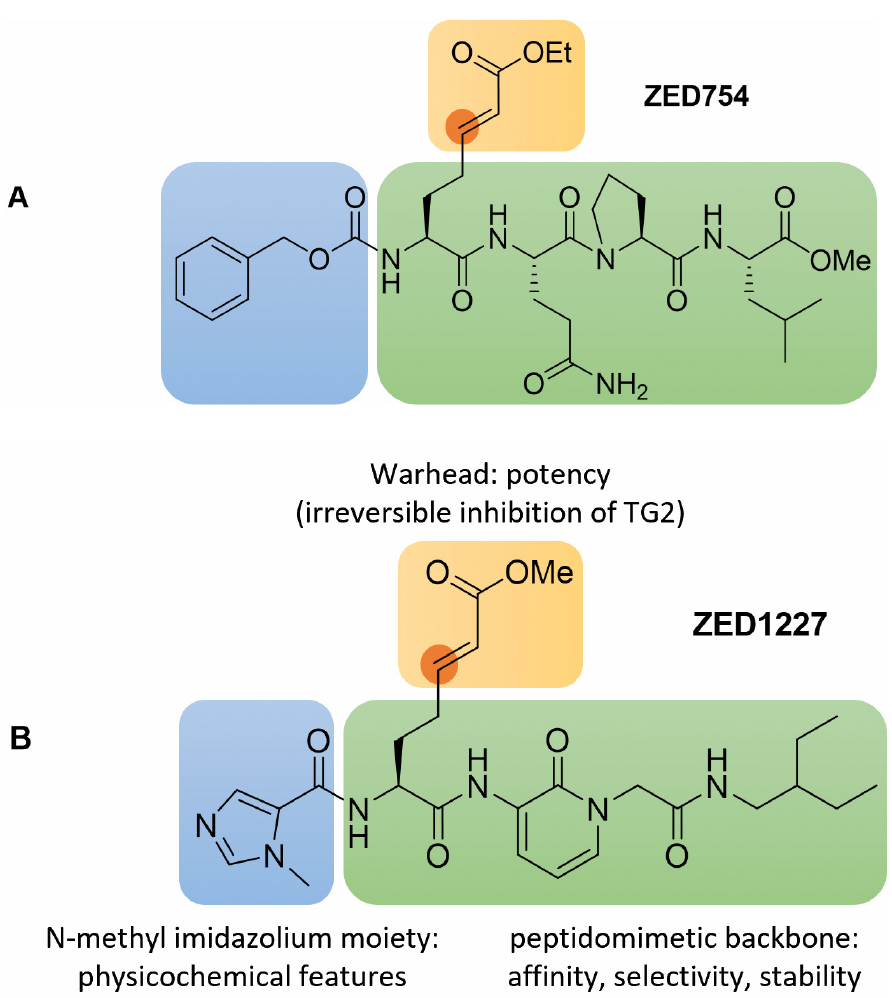
Figure 3. ( A ) The peptide lead structure ZED754 bears the N-terminal Cbz (benzyloxycarbonyl) pro- tecting group (blue) followed by an α , β -unsaturated ethyl ester warhead (yellow; the electrophilic β -carbon is marked in orange) attached to a tripeptide, Gln-Pro-Leu-OMe (green). ZED754 already provides the blueprint for the overall chemical architecture of the drug candidate ZED1227 as illus- trated by the color code. ( B ) The structural features of ZED1227 are highlighted in color as follows: The peptidomimetic backbone (green) provides affinity to the target guiding the Michael acceptor warhead (yellow) into the catalytic center of active tissue transglutaminase. The electrophilic β -carbon (marked in orange) of the E -configured α , β -unsaturated methyl ester is attacked with high efficiency by the uniquely nucleophilic thiolate moiety of Cys277. The N-terminal N-methyl imidazolium heterocycle (blue) is a weak base and thereby contributes to the overall physicochemical features of ZED1227, especially the pH dependent solubility